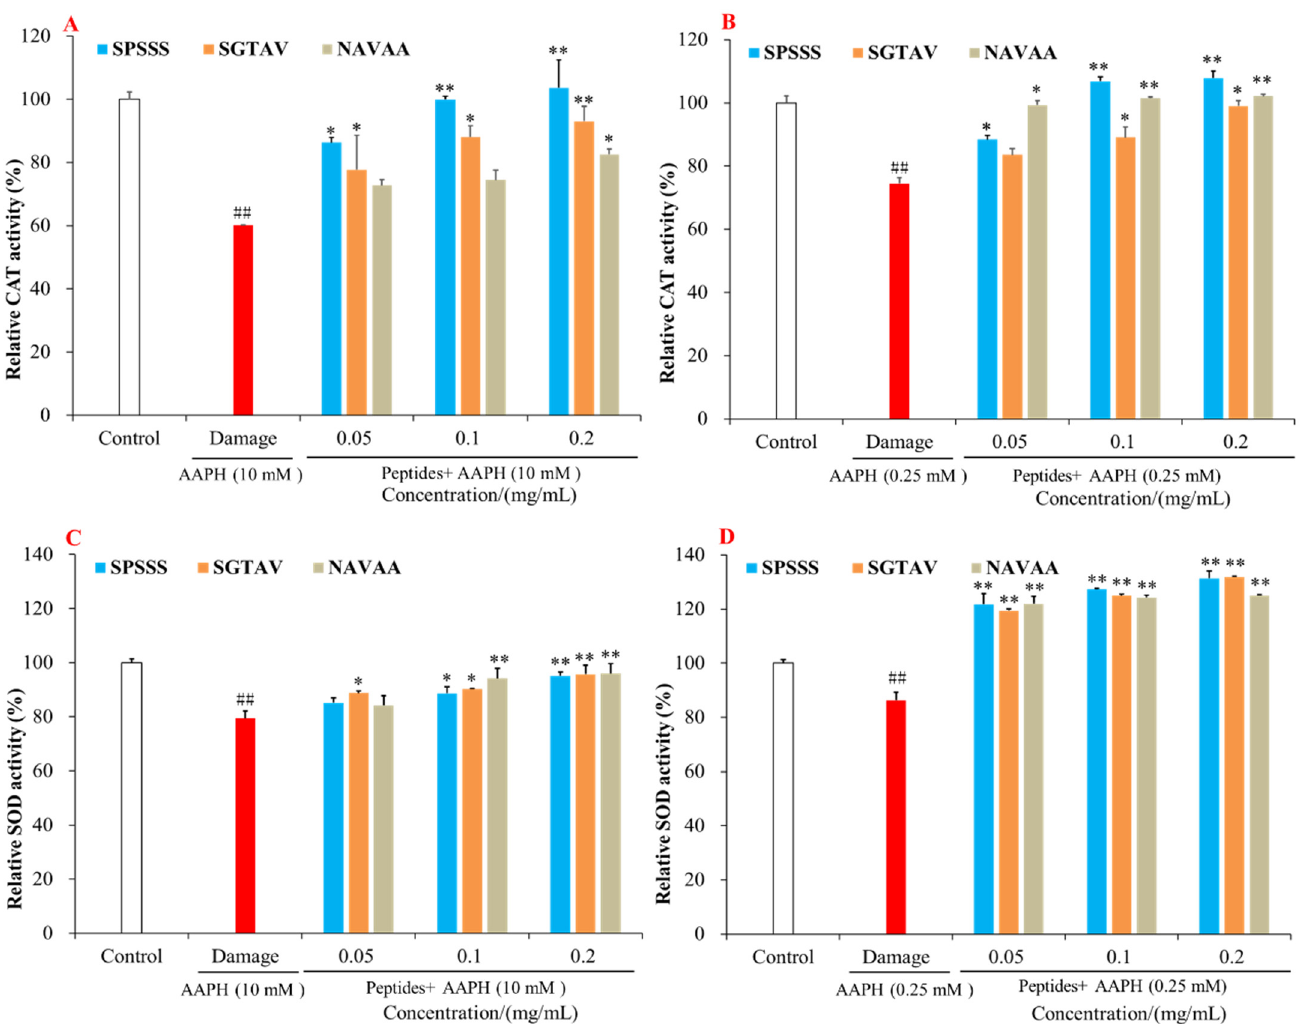
Figure 5. Effect of antioxidant peptides SPSSS, SGTAV, and NSVAA on antioxidant enzymes in AAPH-induced damage cells. ( A ) Effect of antioxidant peptides on CAT in the 50% cell viability model. ( B ) Effects of antioxidant peptides on CAT in the 80% cell viability model. ( C ) Effects of antioxidant peptides effect on SOD in the 50% cell viability model. ( D ) Effects of antioxidant peptides on SOD in the 80% cell viability model. ## indicated p < 0.01 compared with the control group. ** indicated p < 0.01 compared with the AAPH damage group. * indicated p < 0.05 compared with the AAPH damage group.